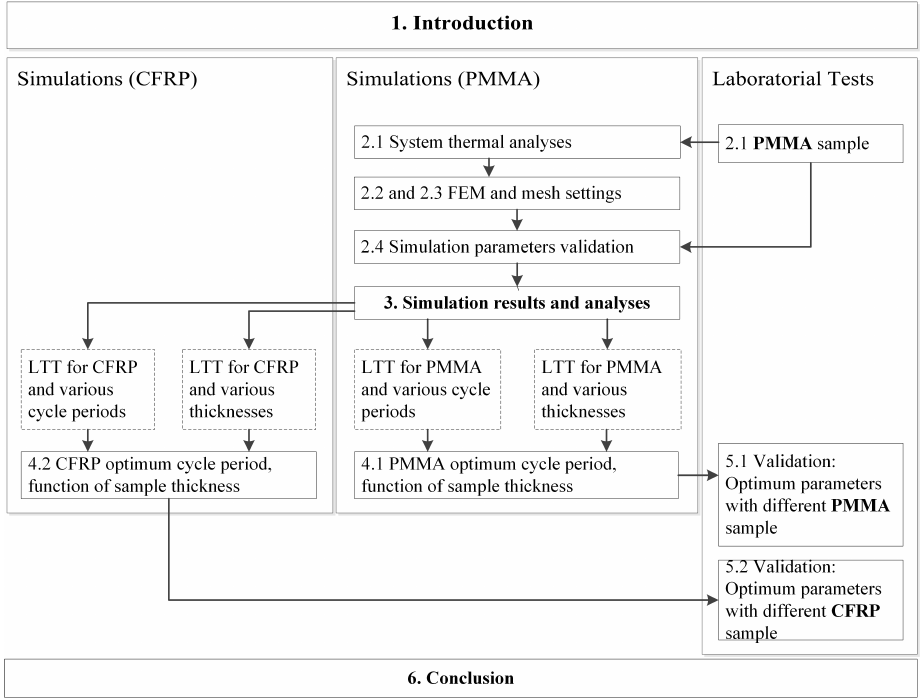
Figure 1. Workflow and article